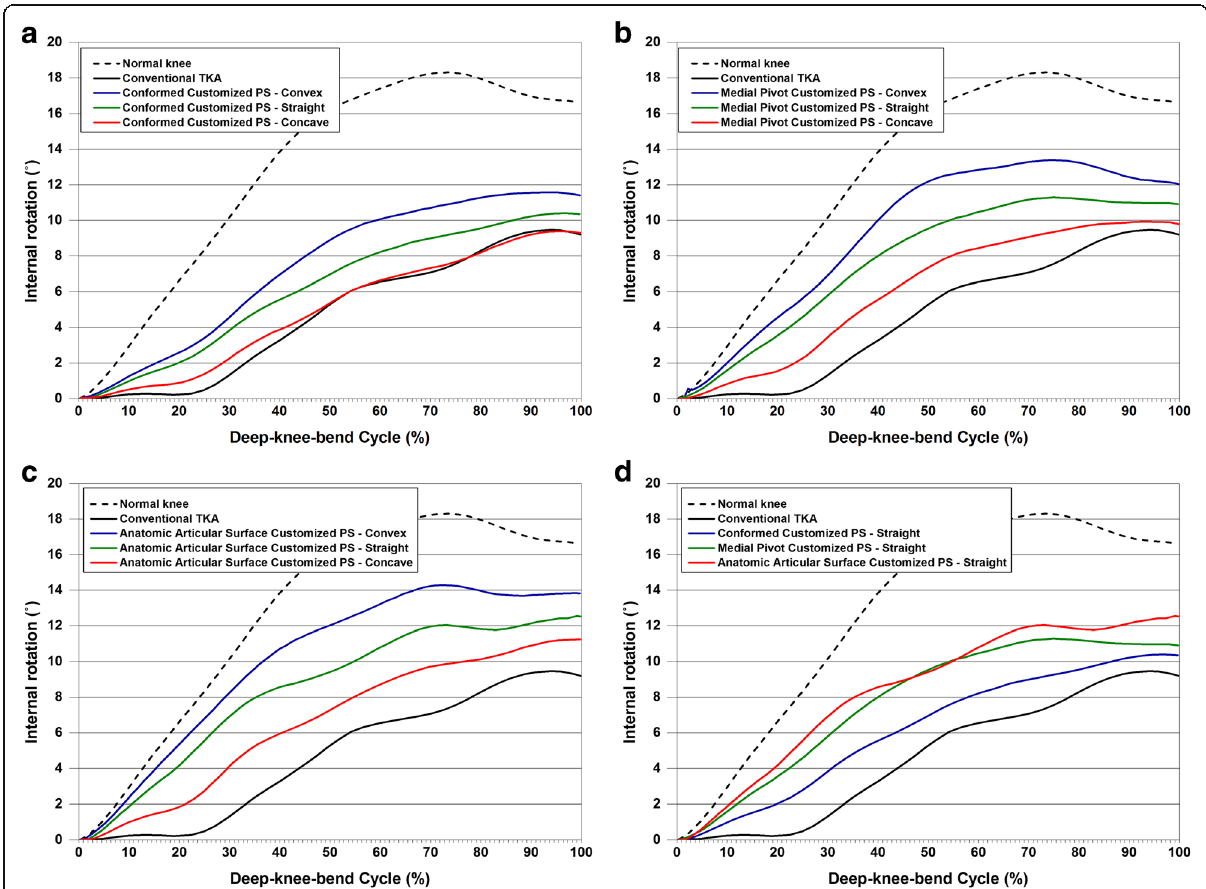
Fig. 7 Comparison of internal rotation in ( a ) Conformed Customized PS-TKA, ( b ) Medial Pivot Customized PS-TKA, and ( c ) Anatomic Articular Surface Customized PS-TKA with regard to different cam designs in the tibial component and ( d ) straight post designed tibial component with regard to different conformity designs in the tibial component under